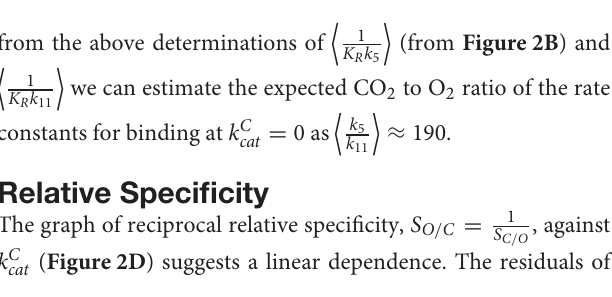
a Table 1 b Savir et al. (2010) ( Table 1 ) c C 3 plant data from Table 1 in Galmés et al. (2014) d higher plants ( Table 1 ) e 25 ◦ C Triticeae data from Table 2 in Prins et al.